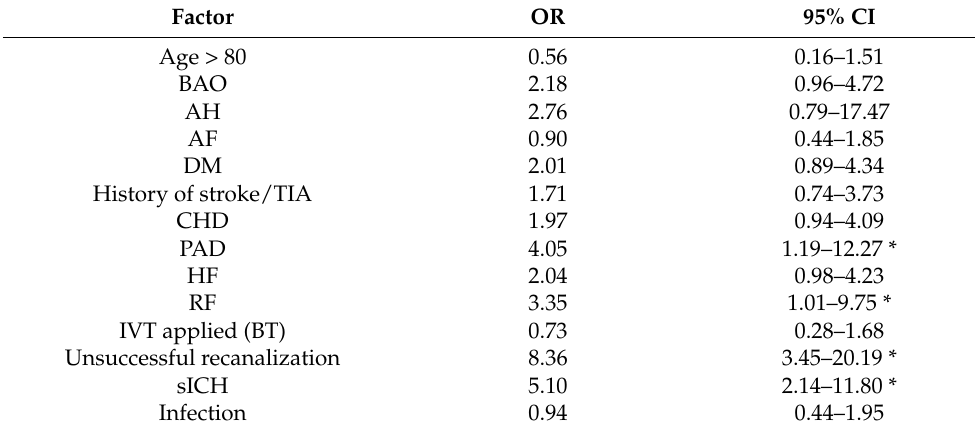
Table 4. Baseline factors, complications, and their association with the risk of early hospital mortality for the whole study